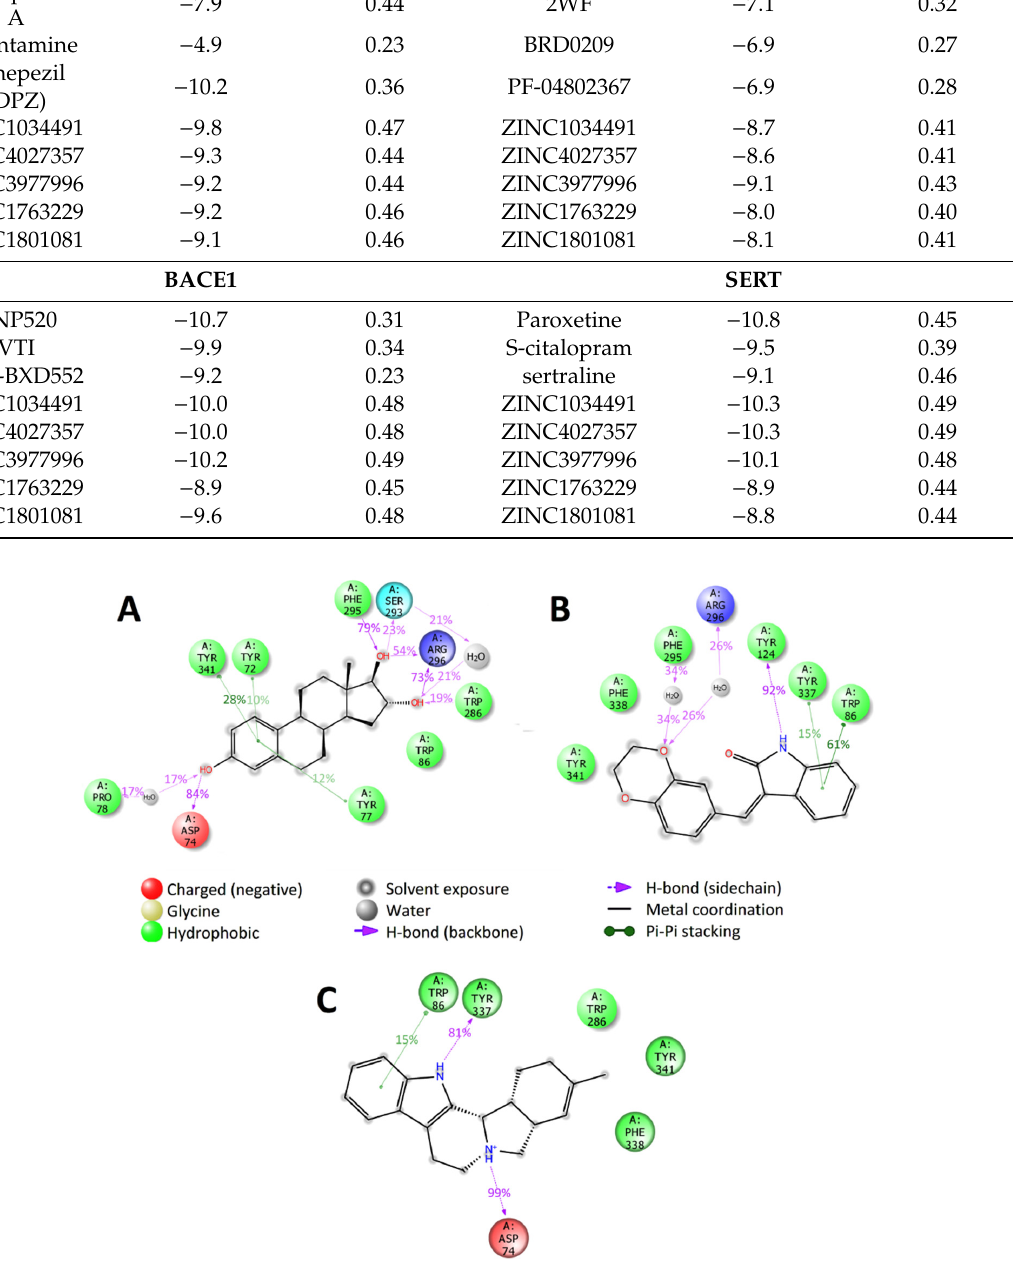
Figure 6. 2D summary diagram of molecular dynamics calculated contacts between AChE and small-molecule ligands ( A ) ZINC3977996, ( B ) ZINC1034491 and ( C ) ZINC4027357. Interactions that occur more than 10% of the simulation time are shown.